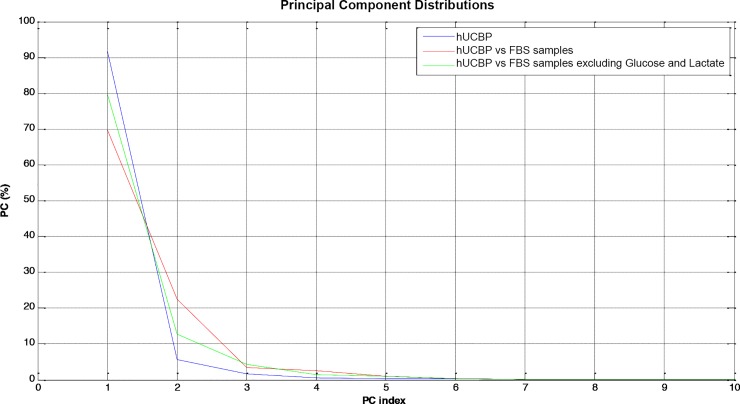
PC contributions for data representation.